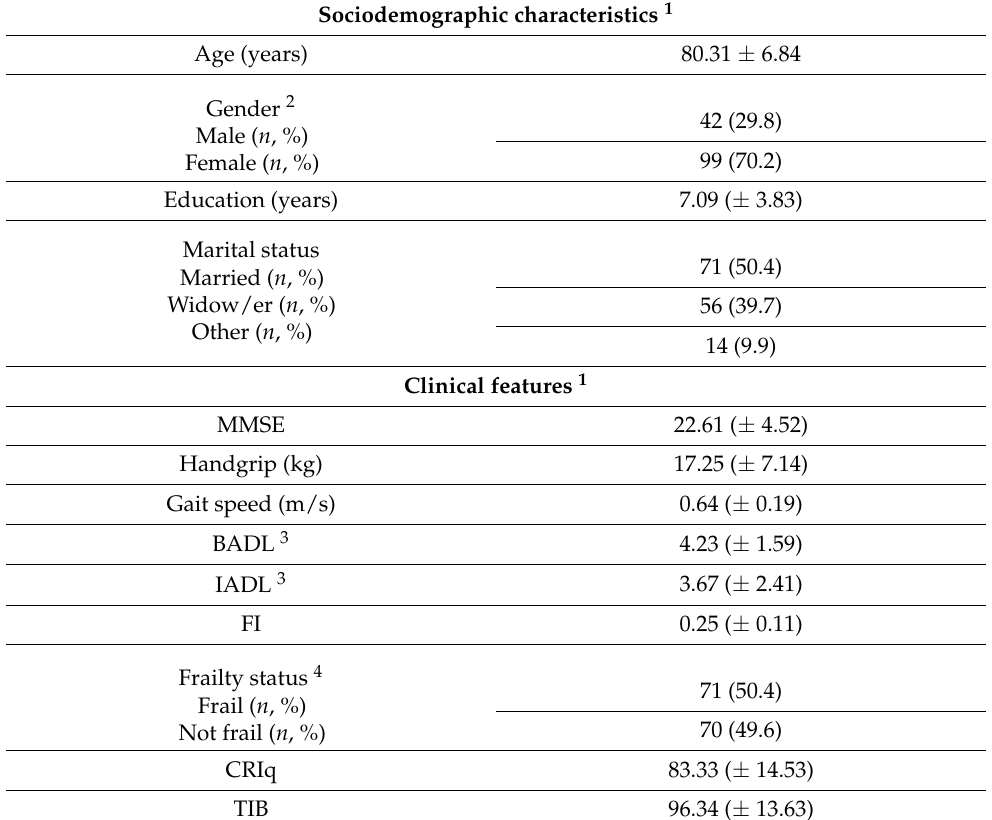
Table 1. Baseline sociodemographic and clinical characteristics of the sample ( n =